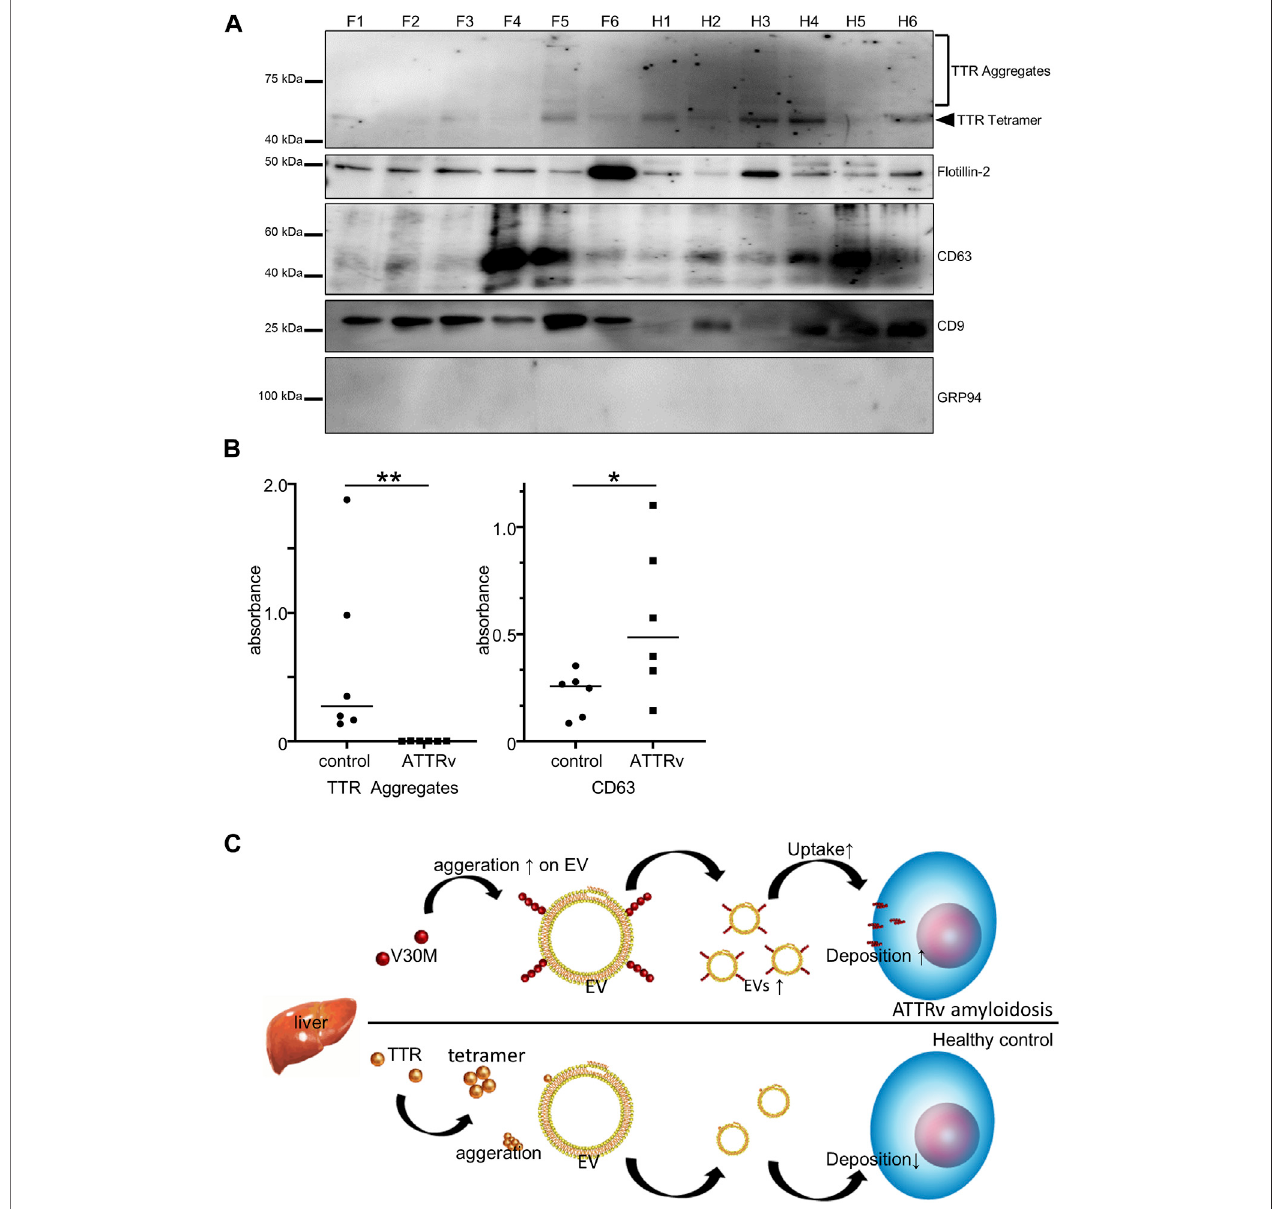
FIGURE 5 | TTR in Serum-derived EVs is reduced in patients with ATTRv amyloidosis. (A) Western blotting analysis of S-EVs derived from patients and controls. TTR ladder bands were more obvious in the controls than in the patients. (B) EV ELISA using serum of controls and patients. Absorbance of TTR aggregates was signi fi cantly higher in the healthy controls than in the patients with ATTRv amyloidosis, whereas absorbance of CD63 was signi fi cantly higher in the patients than in the healthy controls. N = 6, mean ± S.E.; *, p < 0.05; **, p < 0.005, Mann – Whitney U test. (C) A model of EV-mediated V30M-TTR cell deposition. TTR is mainly produced by the liver and secreted into the bloodstream, but the majority of patients with ATTRv amyloidosis produce TTR with the V30M mutation, which promotes aggregationofV30M-TTRonthemembranesofSerum-derivedEVsandfacilitatesdepositiononcellsandothersurfaces,resultinginreducedTTRinSerum-derivedEVs for patients with ATTRv amyloidosis. Increasing the amount of EVs in patients with ATTRv amyloidosis could further promote this